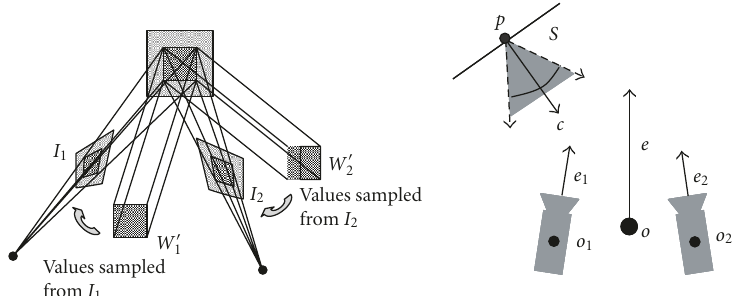
Figure 1: Left: A surface is projectively distorted in images I 1,2 , but the collineations w (cid:2) 1,2 from a planar patch tangent to this surface are not. Right: Illustration of the discussed binocular camera system